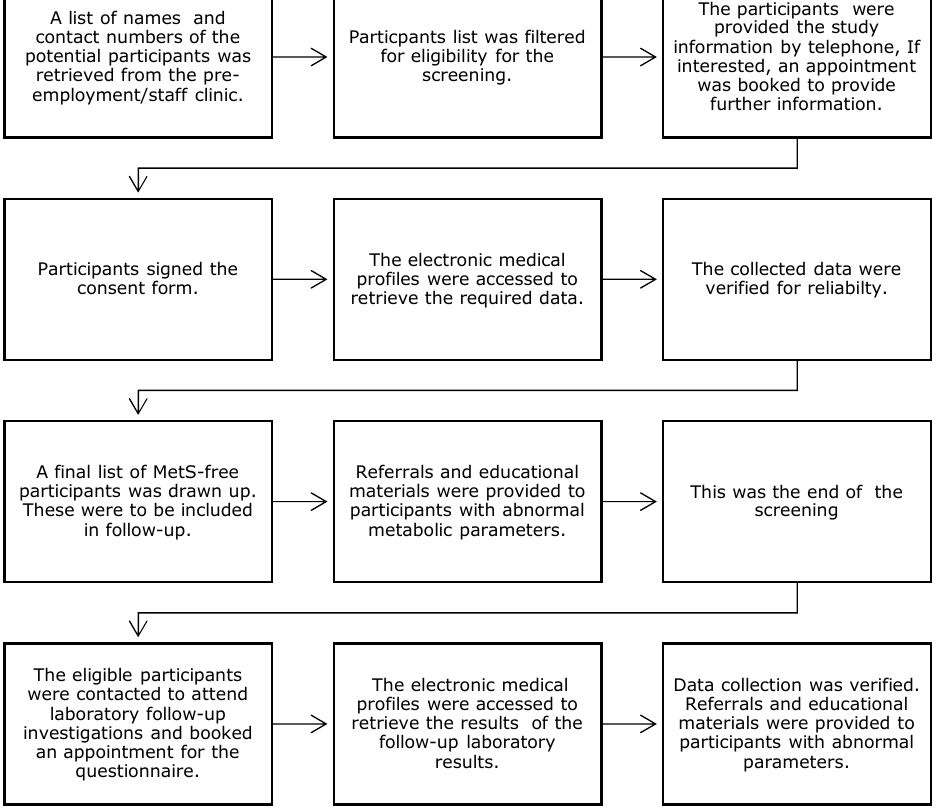
Figure 1. Flow chart summarising the research process in chronological order.